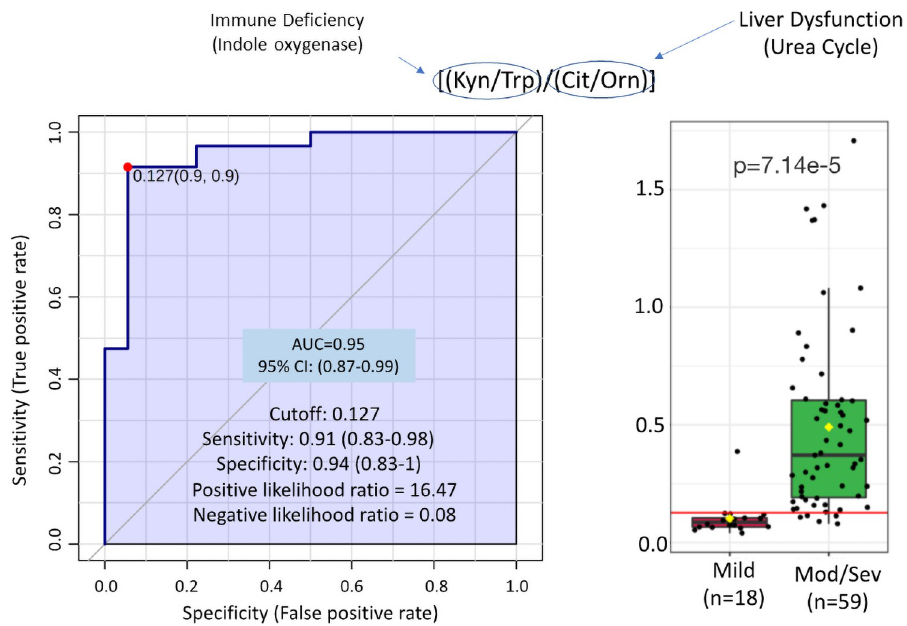
Fig 5. Ratio of immune dysfunction reflected by indole oxygenase activity (Kyn/Trp) over liver dysfunction reflected by ornithine transcarbamylase (Cit/Orn) discriminates patients with mild vs moderate/severe outcomes. 100-fold Cross Validation = 0.82, Predictive Accuracy (100 permutations) p = 1.00E-03. https://doi.org/10.1371/journal.pone.0259909.g005 Table 3. Logistic regression models for selected COVID-19-related outcomes adjusted for age, sex, and BMI. Moderate/Severe COVID Needed ventilator Any complications besides pneumonia